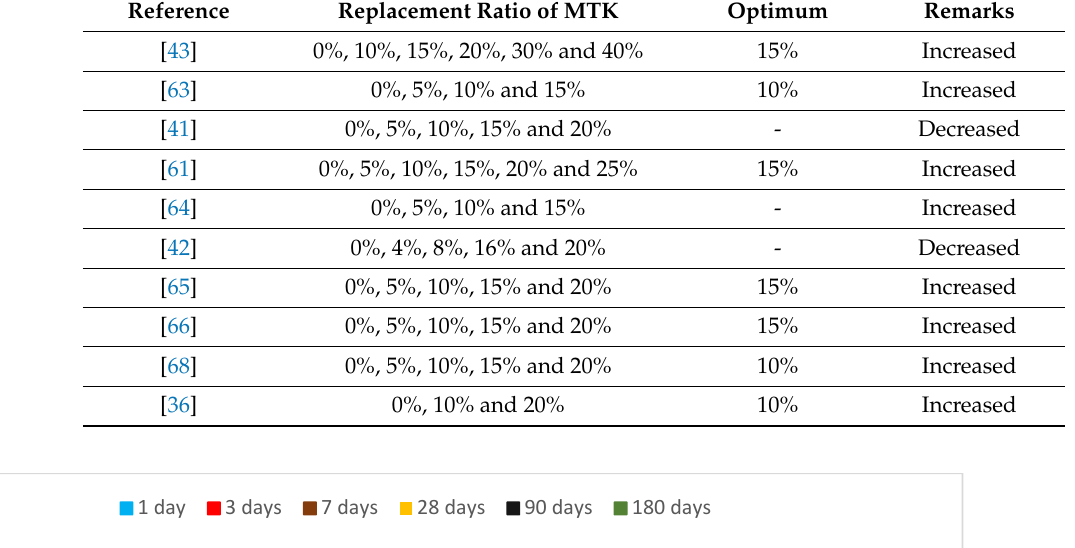
Table 5. Summary of the tensile strength of concrete.